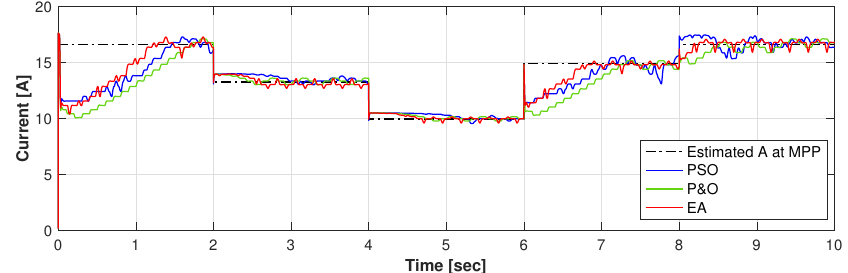
Figure 21. Current from the PV source ( i pv ) against time profiles from high power simulations.